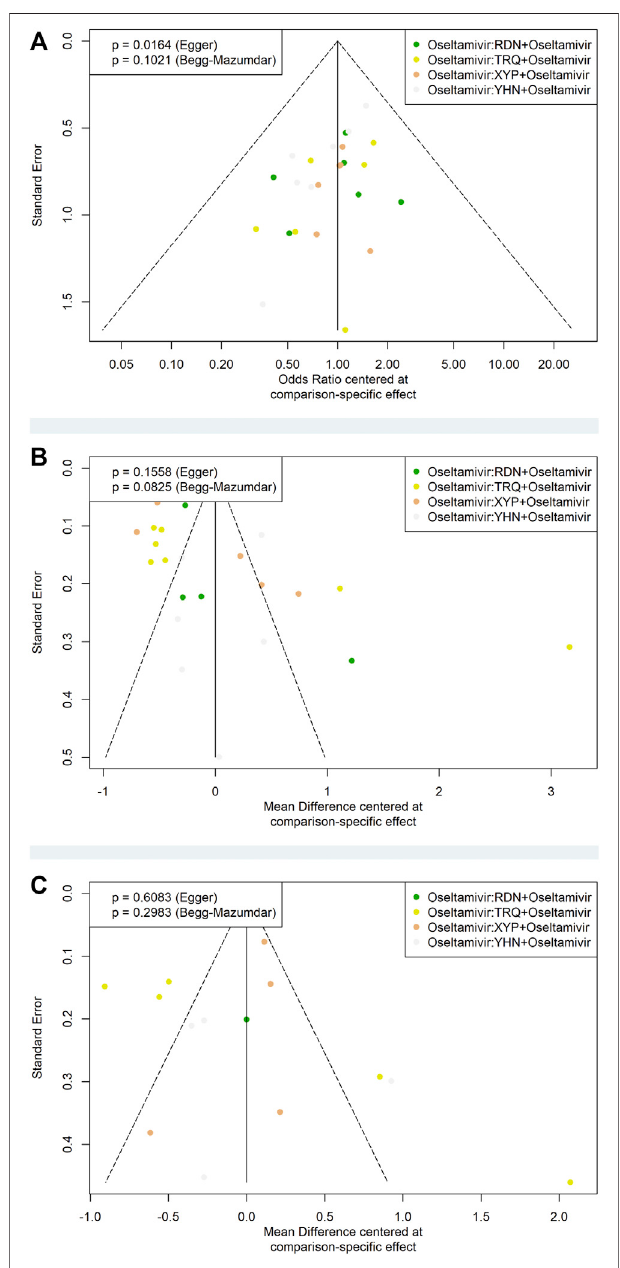
FIGURE 5 | Funnel plots of primary outcomes. XYP, Xiyanping; RDN, Reduning; TRQ, Tanreqing; YHN, Yanhuning. (A) Response rate; (B) disappearance time of fever; (C) disappearance time of